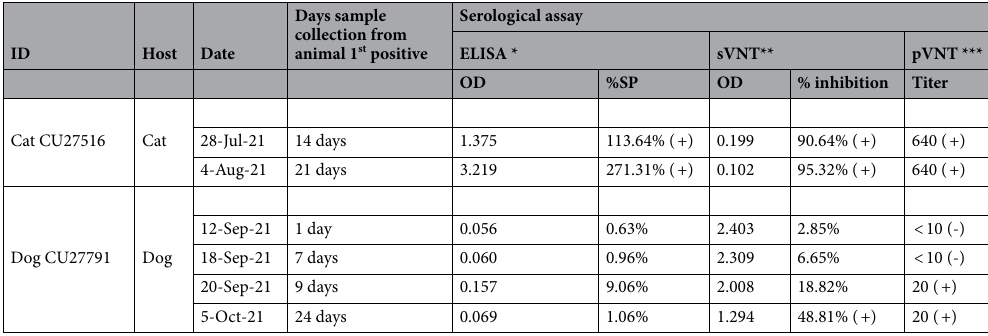
Table 4. Serological test result of protein-based ELISA, sVNT and pVNT for SARS-CoV-2 antibodies in COVID-19 positive cat and dog. *ELISA: ID Screen® SARS-CoV-2 Double Antigen Multi-species ELISA kit (ID VET, Montpellier, France). For the cutoff values, S/P% ≥ 60% is postive, S/P% 50–60% is suspected, and < 50% is negative. **sVNT (Virus neutralization test): cPass SARS-CoV-2 Neutralization Antibody Detection Kit (GenScript Biotech, Jiangsu, China). The cutoff values were defined as follows; positive if % inhibition ≥ 20% is positive and negative otherwise. ***pVNT (Pseudotype Virus neutralization test): pVNT was determined against Lentiviral pseudovirus expressing spike of SARS-CoV-2 strain Wuhan-Hu-1 (Genbank NC_045512). Serum dilution that gave a 50% reduction in GFP signal (IC50) was considered positive. The titer of ≥ 10 is considered postive and negative